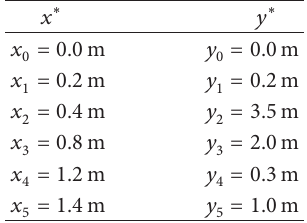
Table 1: Points used in order to generate the desired